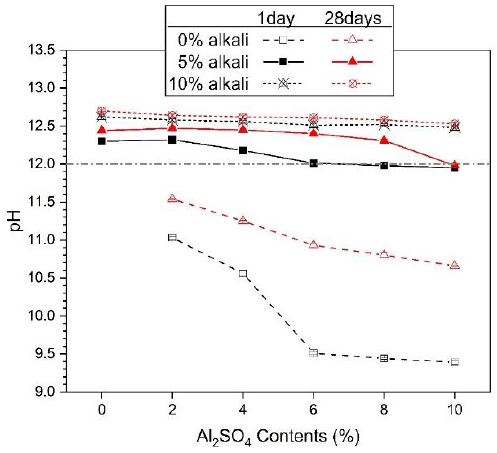
Figure 8 . The pH values for AASC pastes with activator. Figure 8. The pH values for AASC pastes with